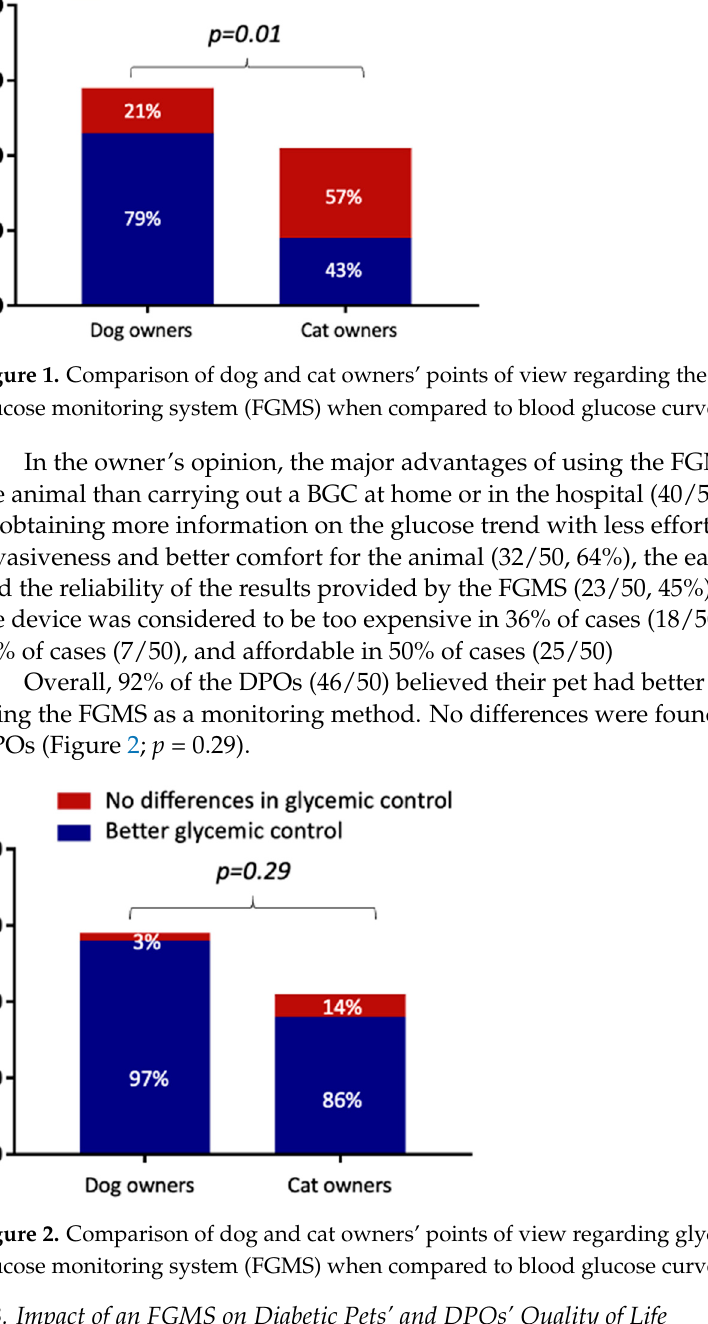
Figure 3. Comparison of dog and cat owners’ points of view regarding problems related to prema ‐ ture sensor detachment. In addition, 60% (13/21) of cat DPOs reported that the sensor was not well tolerated, and a significant difference was found when compared to dog DPOs (Figure 4).